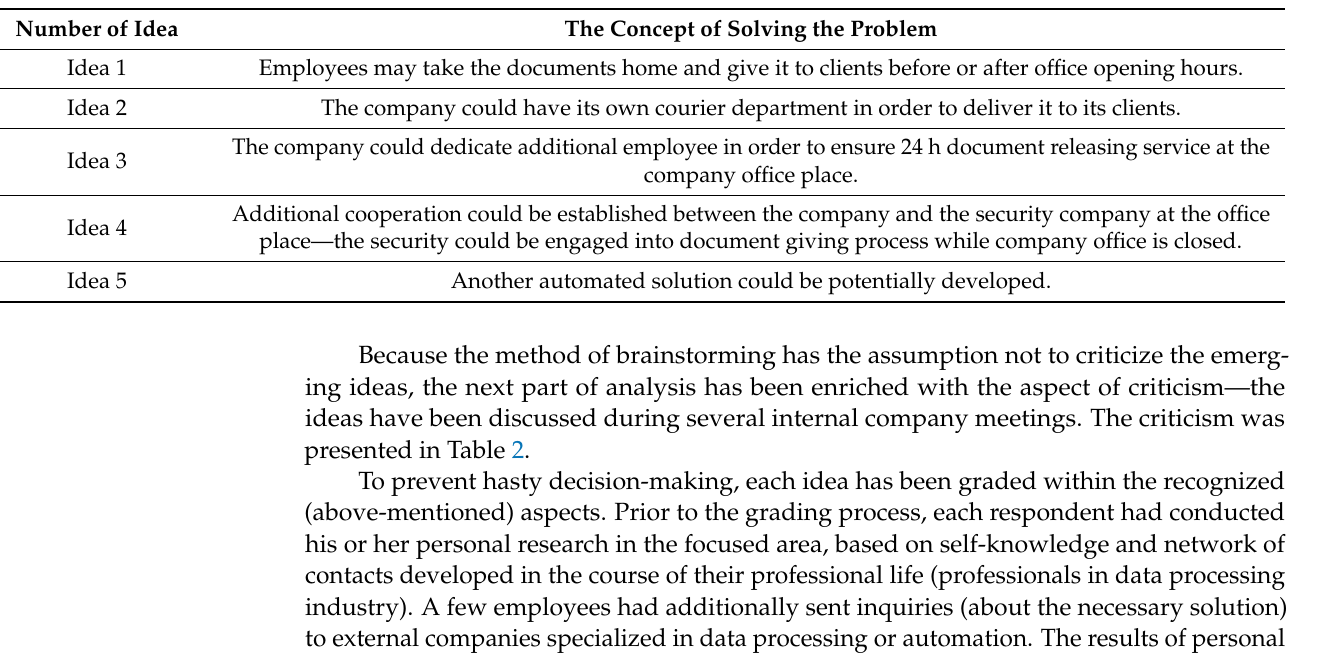
Table 1. The outcome of a brainstorming session.